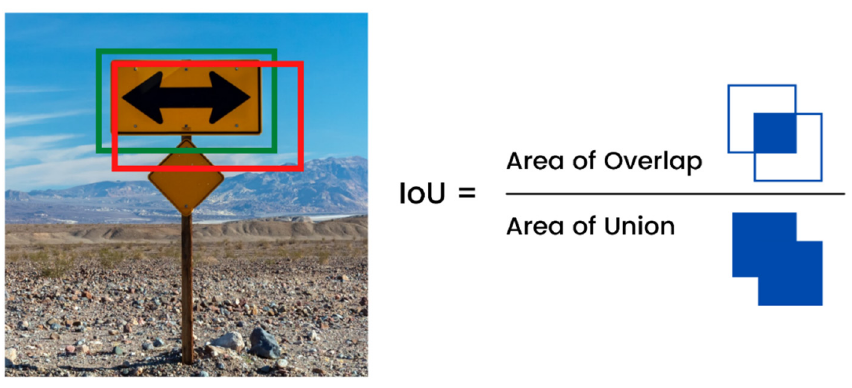
Figure 6. IOU calculation [14].